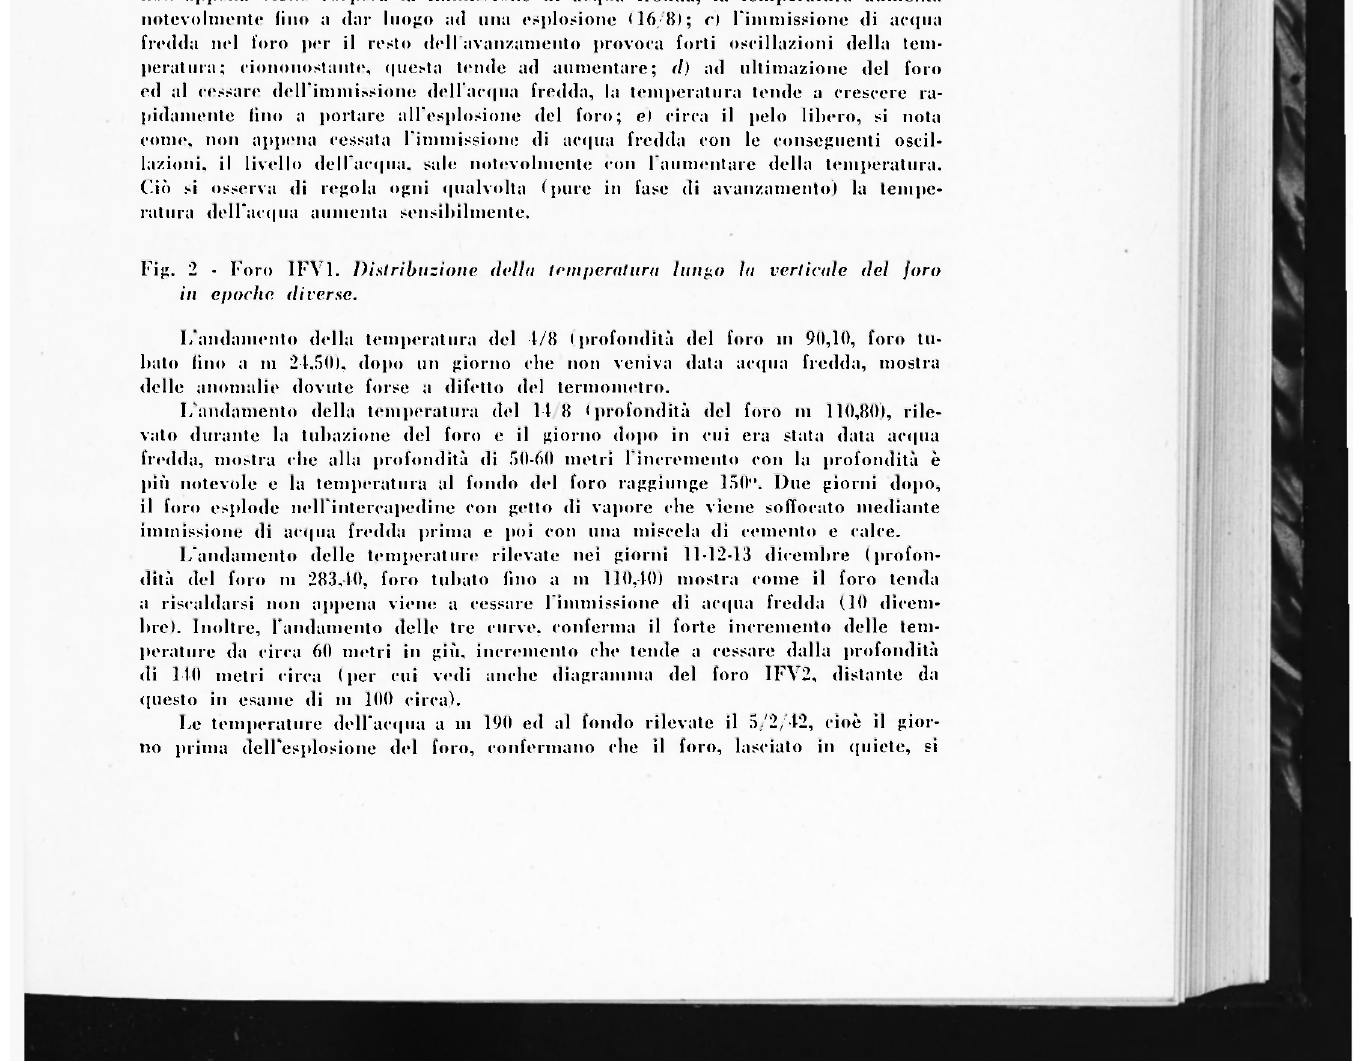
Fig. 2 - Foro IFV1. Distribuzione della temperatura lungo la verticale del foro in epoche